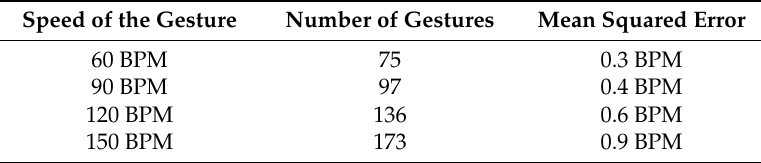
Table 6. Mean squared error